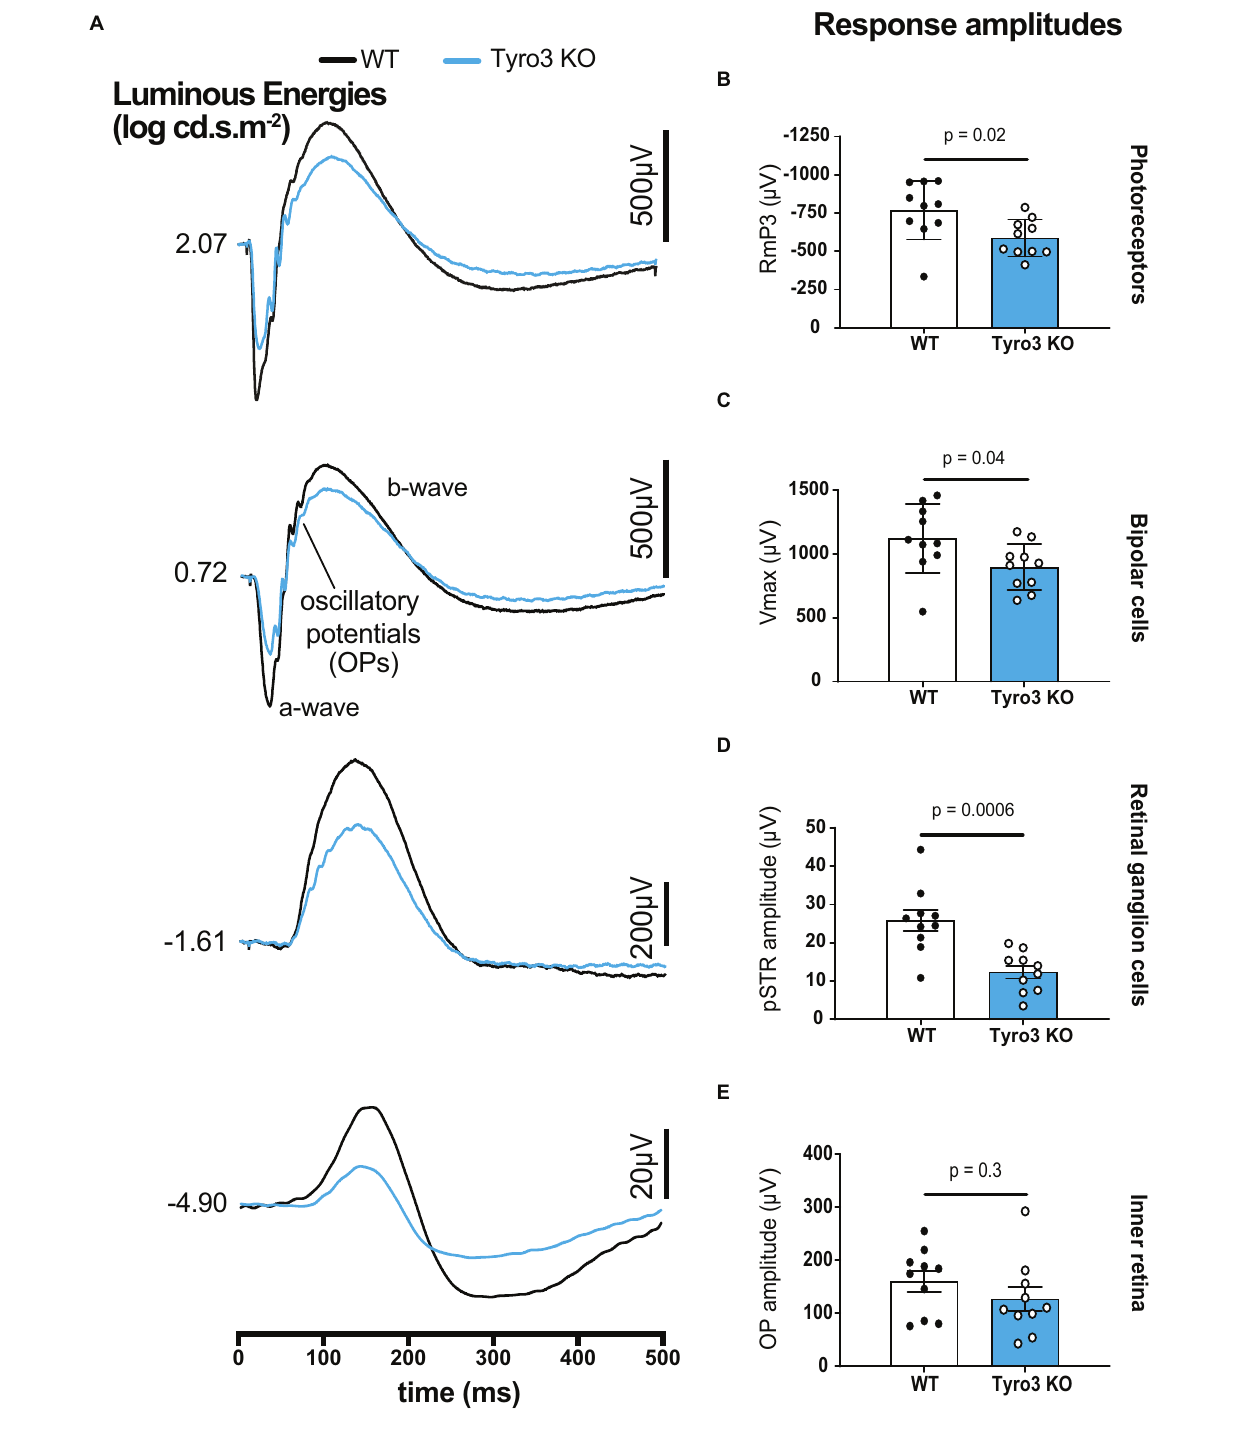
FIGURE 1 | Loss of Tyro3 is associated with a reduction in retinal function. Dark-adapted full-field ERGs were performed to examine retinal function in WT and Tyro3 KO mice ( n = 10/genotype), enabling analysis of light evoked responses from various retinal cell classes. (A) Average waveforms from WT mice (black) and KO mice (blue) elicited at selected light levels (bottom to top, dimmest to bright flashes, –4.90 to 2.07 log cd.s.m - 2 ). Tyro3 deficient mice showed significant reductions in amplitudes of photoreceptors ( B ; p = 0.02), bipolar cells ( C ; p = 0.04) and retinal ganglion cells ( D ; p = 0.006) compared with WT mice. No significant difference was observed in the amplitude of the oscillatory potentials which arise from the inner retina, reflecting amacrine cell pathways ( E ; p = 0.3). Results are presented as mean ± SEM; p -value of mean differences were calculated using a two-tailed, unpaired Student’s t -test.